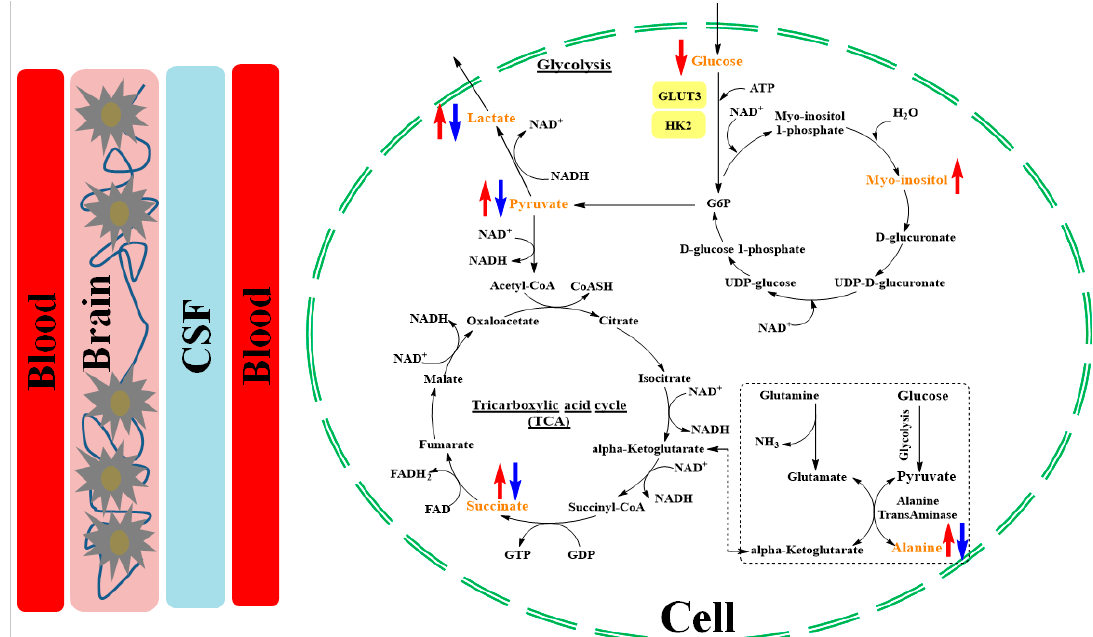
Figure 6. Schematic representation of altered metabolites during systemic inflammatory response under BSI condition. Blood delivers the glucose to tissues, where it reaches cells through diffusion and by glucose transporters. Glucose is converted to G6P and then pyruvate through glycolysis, leading to lactate accumulation as well as an elevated tricarboxylic acid cycle. The altered metabolites are shown in yellow. Red and blue arrows represent SE + TPN and SE + COL, respectively, and denote higher and lower levels of the respective metabolites compared to controls.